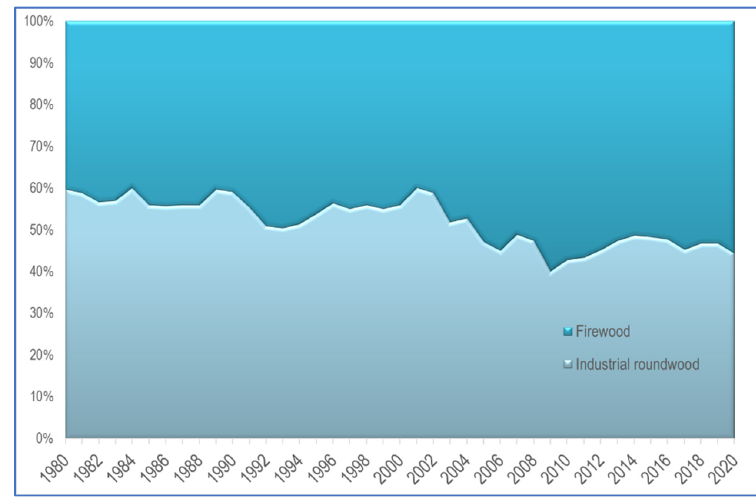
Figure 3. The proportion of industrial wood and firewood in the total net roundwood removal.